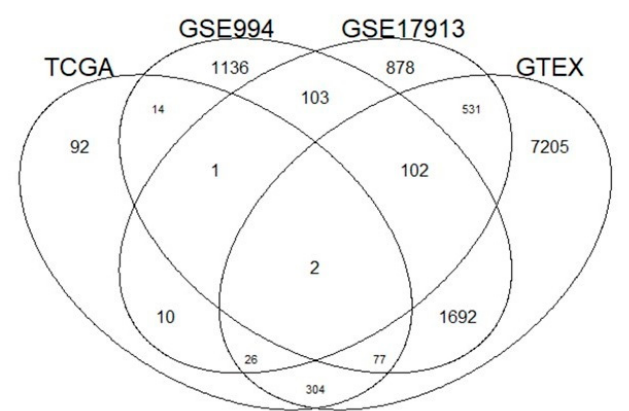
Figure 3. Venn diagram of genes correlated with ACE2 expression levels in four different datasets (The Cancer Genome Atlas (TCGA), GSE994, GSE17913 and Genotype-Tissue Expression (GTEx)). Ninety-four genes are reported by TCGA-LUAD and GSE994, 39 genes between TCGA-LUAD and GSE17913 and 409 common genes between TCGA-LUAD and GTEx.